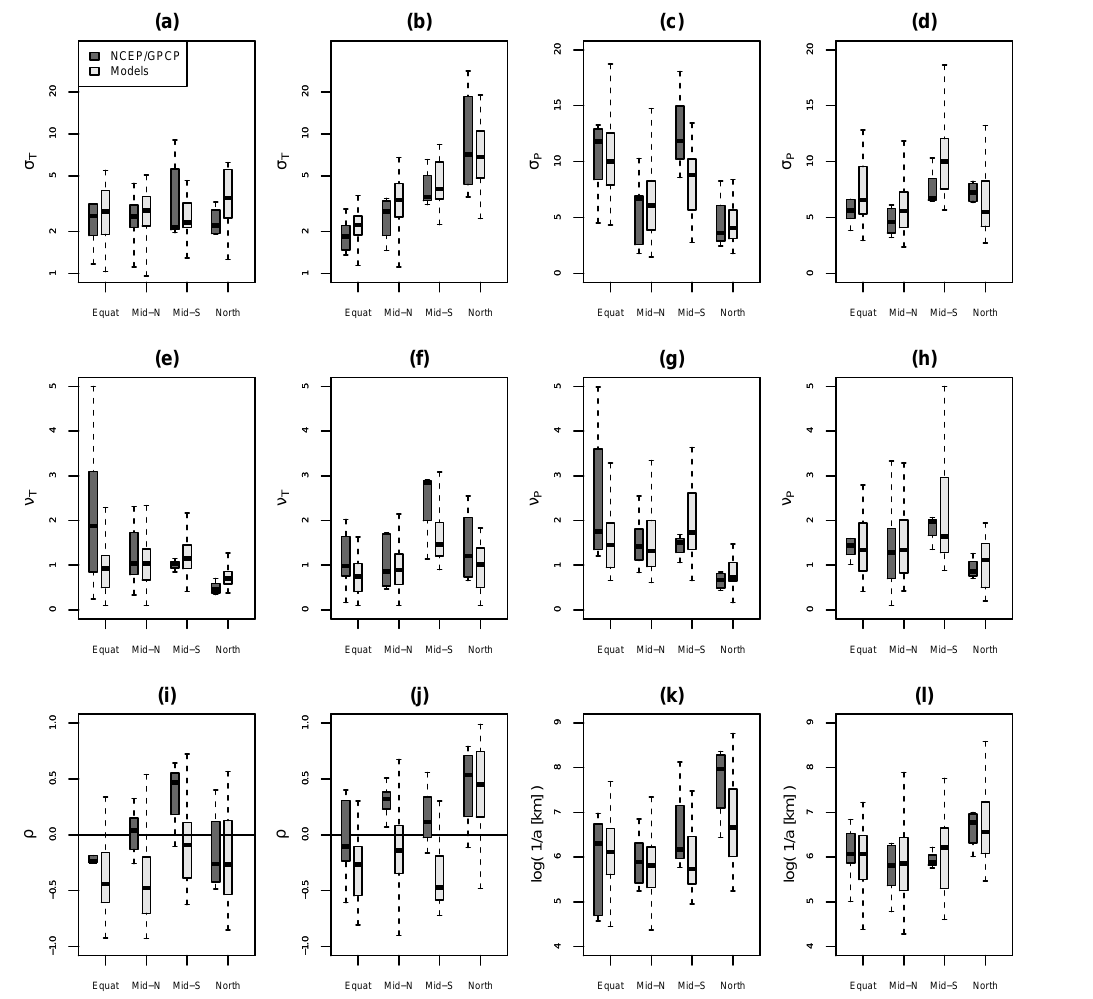
Figure 8. Parameter estimates for observational proxy data and GCMs for each season by latitude band. (a) JJA and (b) DJF for ˆ σ T , (c) JJA and (d) DJF for ˆ σ P , (e) JJA and (f) DJF for ˆ ν T , (g) JJA and (h) DJF for ˆ ν P , (i) JJA and (j) DJF for ˆ ρ , and (k) JJA and (l) DJF for 1 / ˆ a (in log